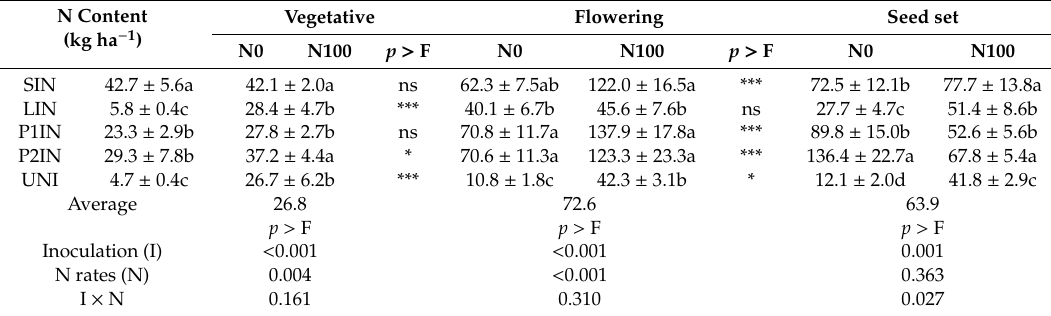
Table 4. Average ( ± standard error) leaf nitrogen (N) yield (kg ha − 1 ).